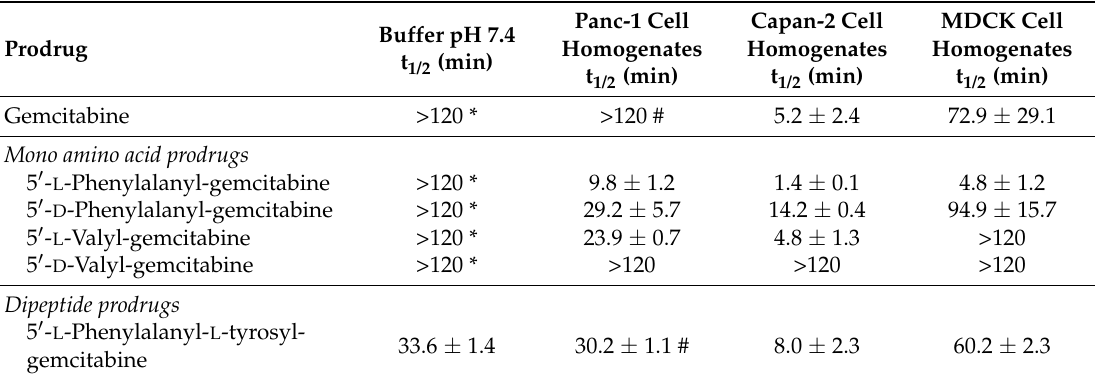
Table 1. Stability of gemcitabine prodrugs in pH 7.4 Buffer and pancreatic cancer cell homogenates. (Mean ± S.D., n = 3).